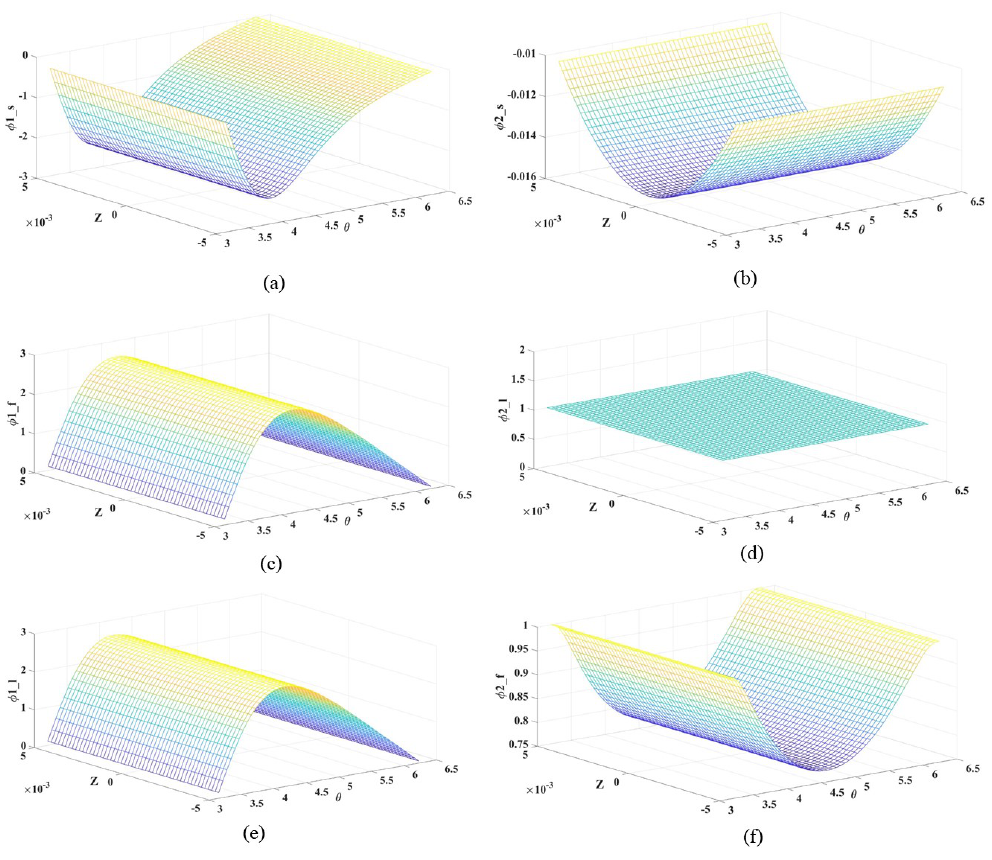
Figure 6. Graphic of φ 1 ( Ω , (cid:101) , θ ) and φ 2 ( Z ) . ( a ) φ 1_ s _1 ( φ 1_ s _2 ) of the short bearing. ( b ) φ 2_ s _1 ( φ 2_ s _2 ) of the short bearing. ( c ) φ 1_ c of the long bearing. ( d ) φ 2_ c of the long bearing. ( e ) φ 1_ f of the finite length bearing. ( f ) φ 2_ f of the finite length bearing.